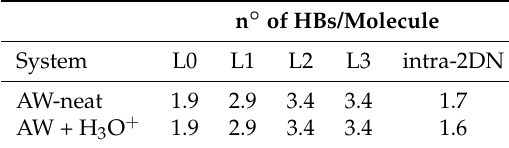
Table 1. Average number of HBs per water molecule as a function of the layer they belong to (L0, L1, L2 and L3, see Figure 1), calculated by averaging over the four independent DFT-MD trajectories of the acidic air-water interface (one hydronium ion located in the BIL) and for the neat air-water interface [26]. The fluctuations in the numbers in between the four trajectories for the acidic interface are negligible. The number of intra-2DN HBs (HBs formed between two water molecules both belonging to the 2DN) per water molecule is also reported for both the acidic and neutral AW